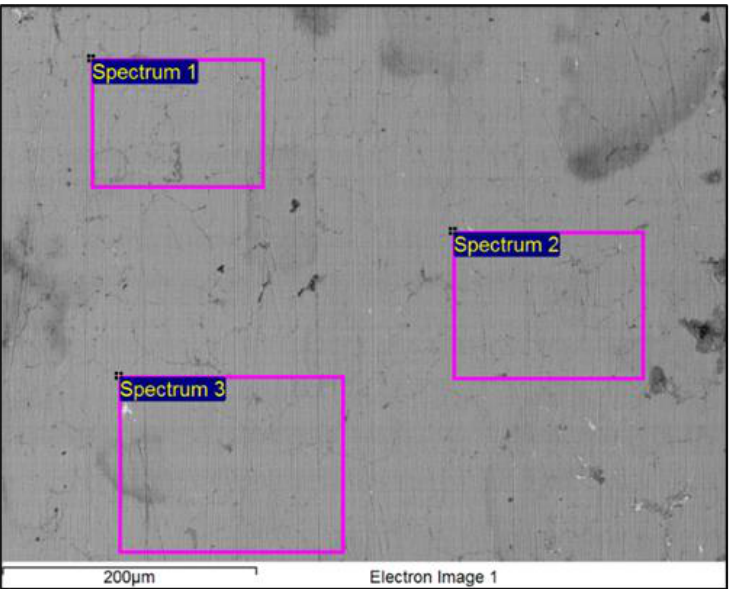
Figure 4. Microstructure of the polished dark sample ’ s surface with areas for EDX analysis.